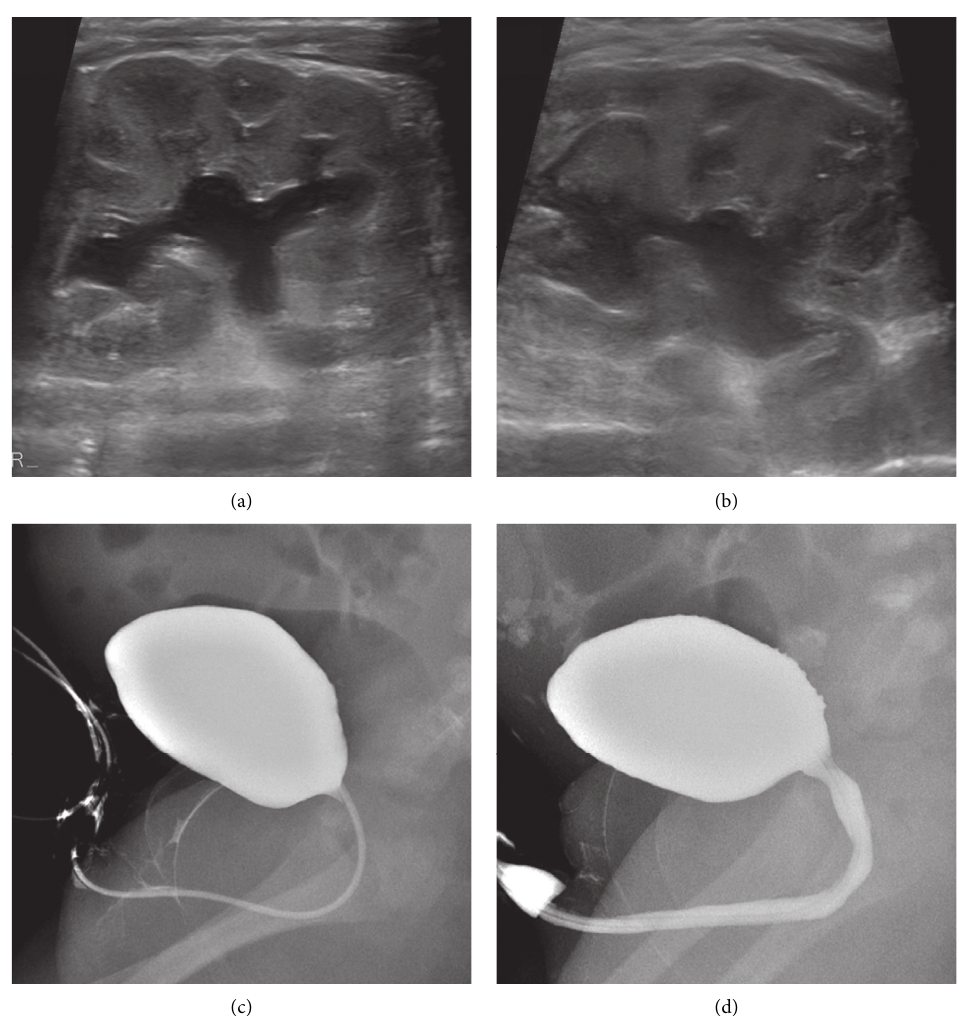
Figure 1: Renal and bladder imaging. (a). Hydronephrosis of the left kidney. (b). Hydronephrosis of the right kidney. (c). Micturation cystourethrogram (filling phase-normal bladder wall). (d) Micturation cystourethrogram (voiding phase-normal